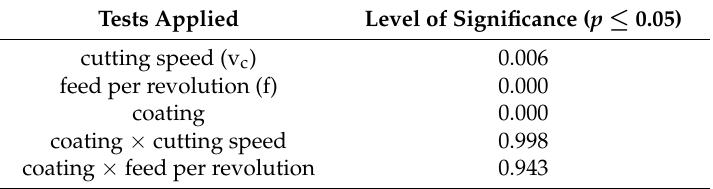
Table 8. Significance level of the effect of cutting parameters on temperature